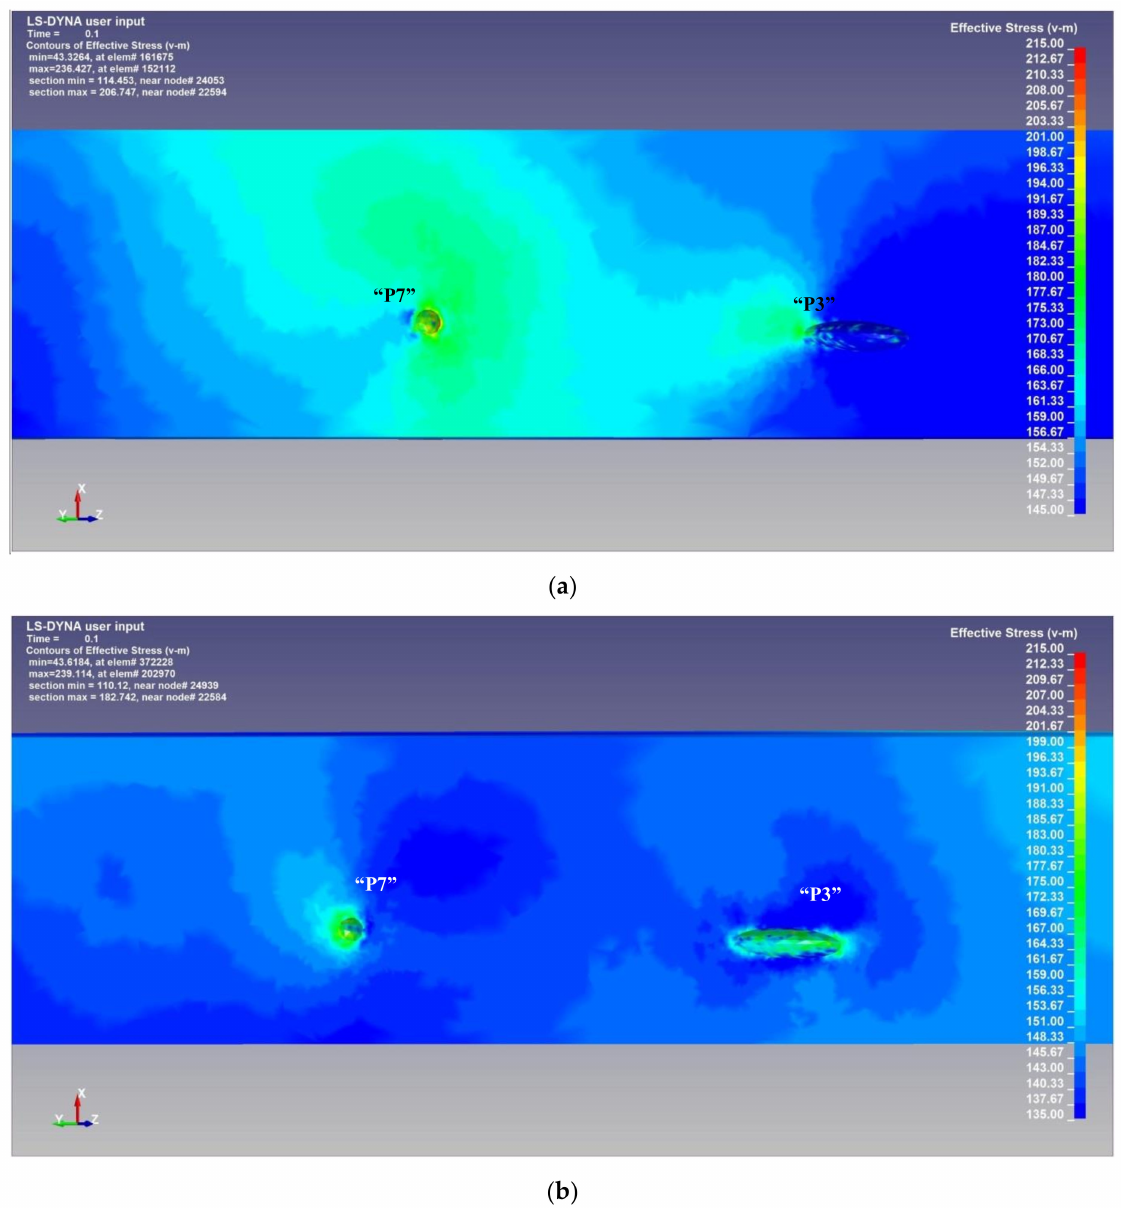
Figure 18. Comparison between the induced stress fields of “P3” and “P7” (units in MPa): ( a ) first loading scenario and ( b ) second loading